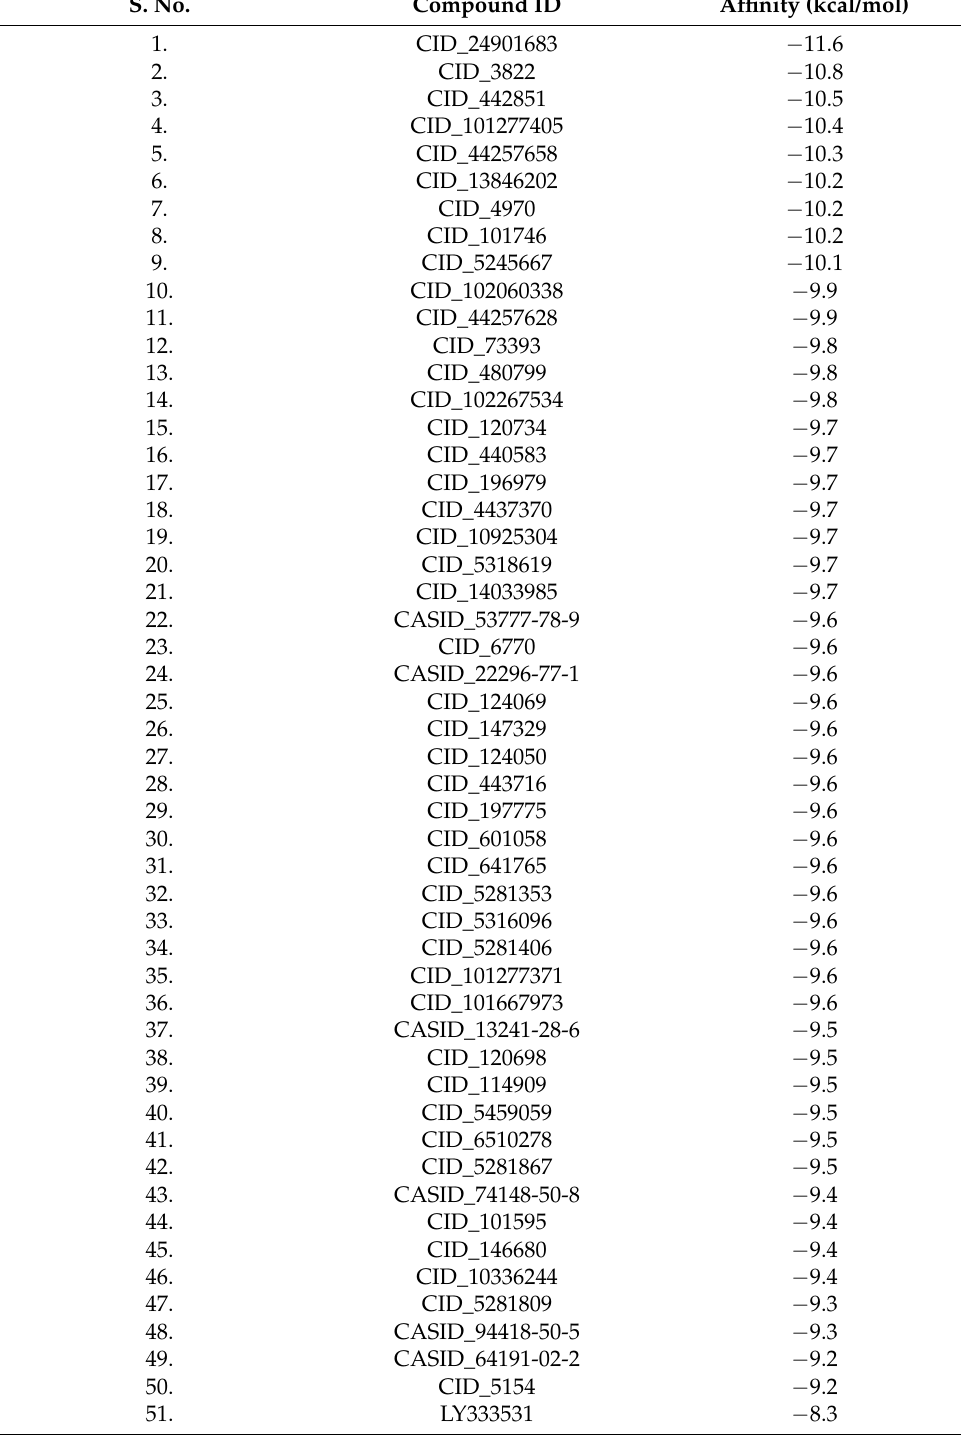
Table 1. The selected top 50 molecules based on the binding affinity toward